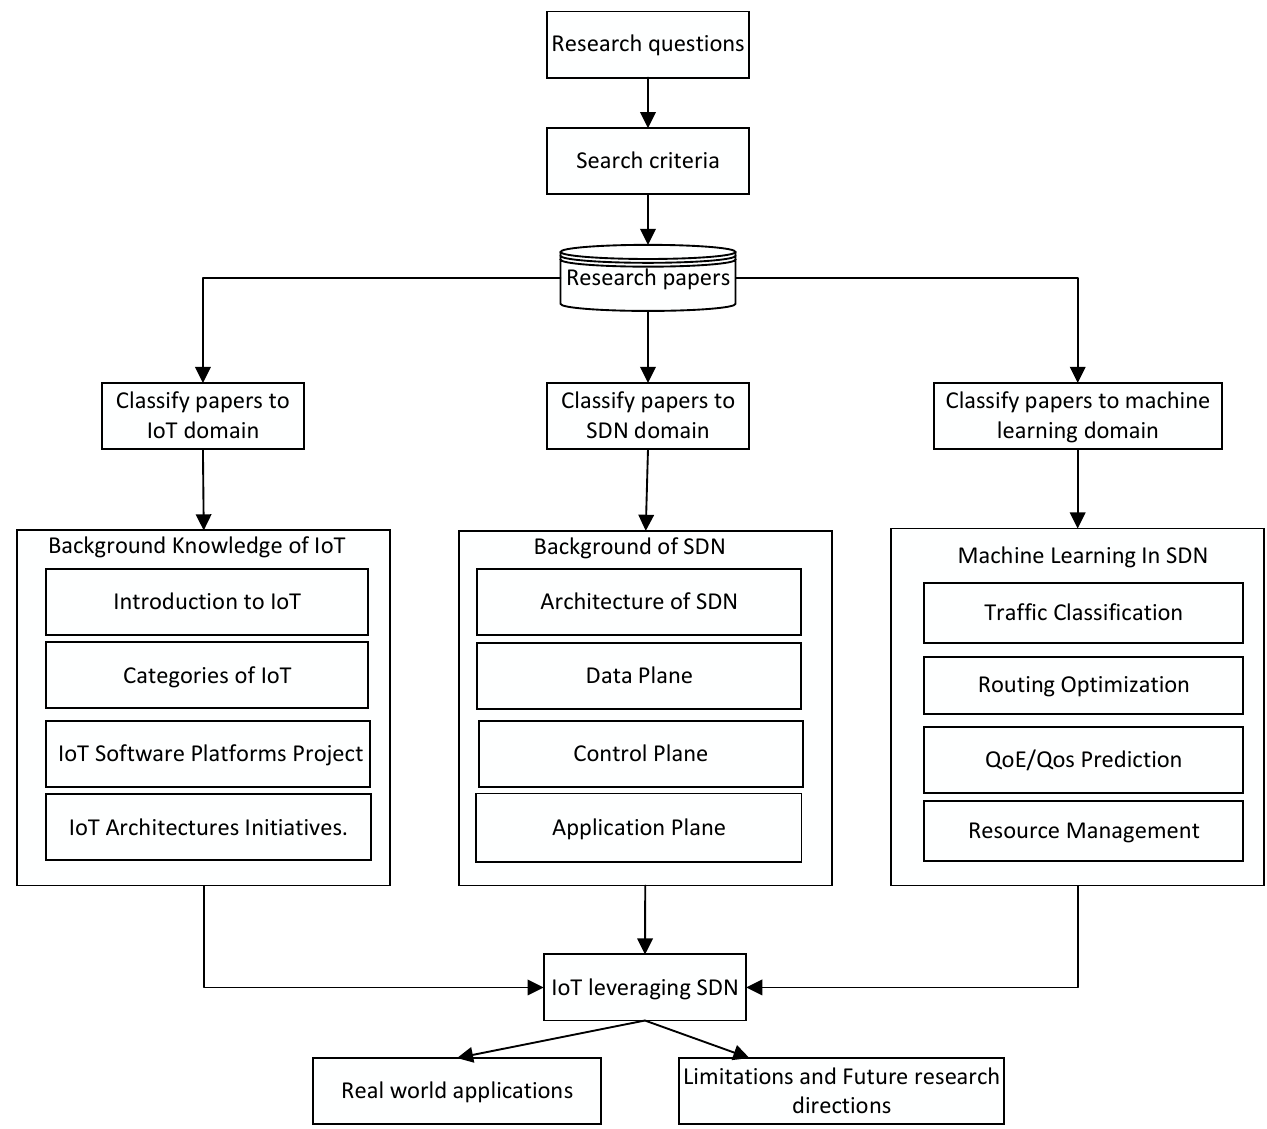
Figure 1. Proposed research flow for Internet of Things (IoT) leveraging software-defined networking